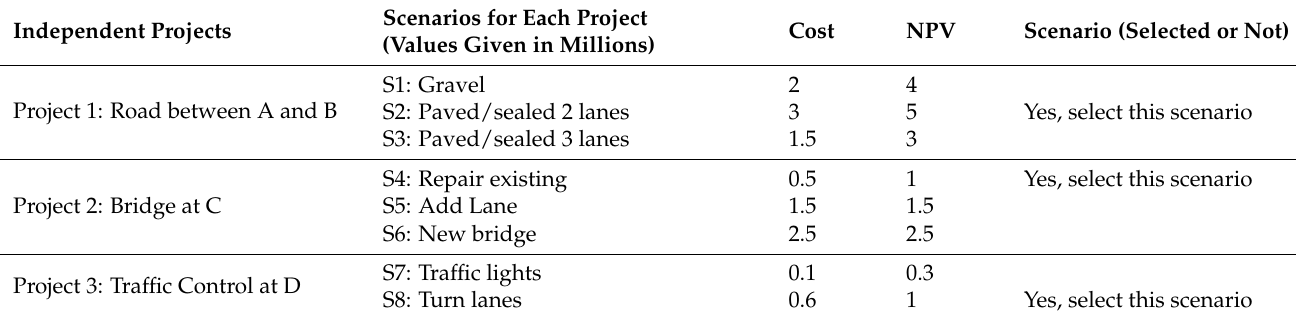
Table 9. The best combination of projects (Source: Own